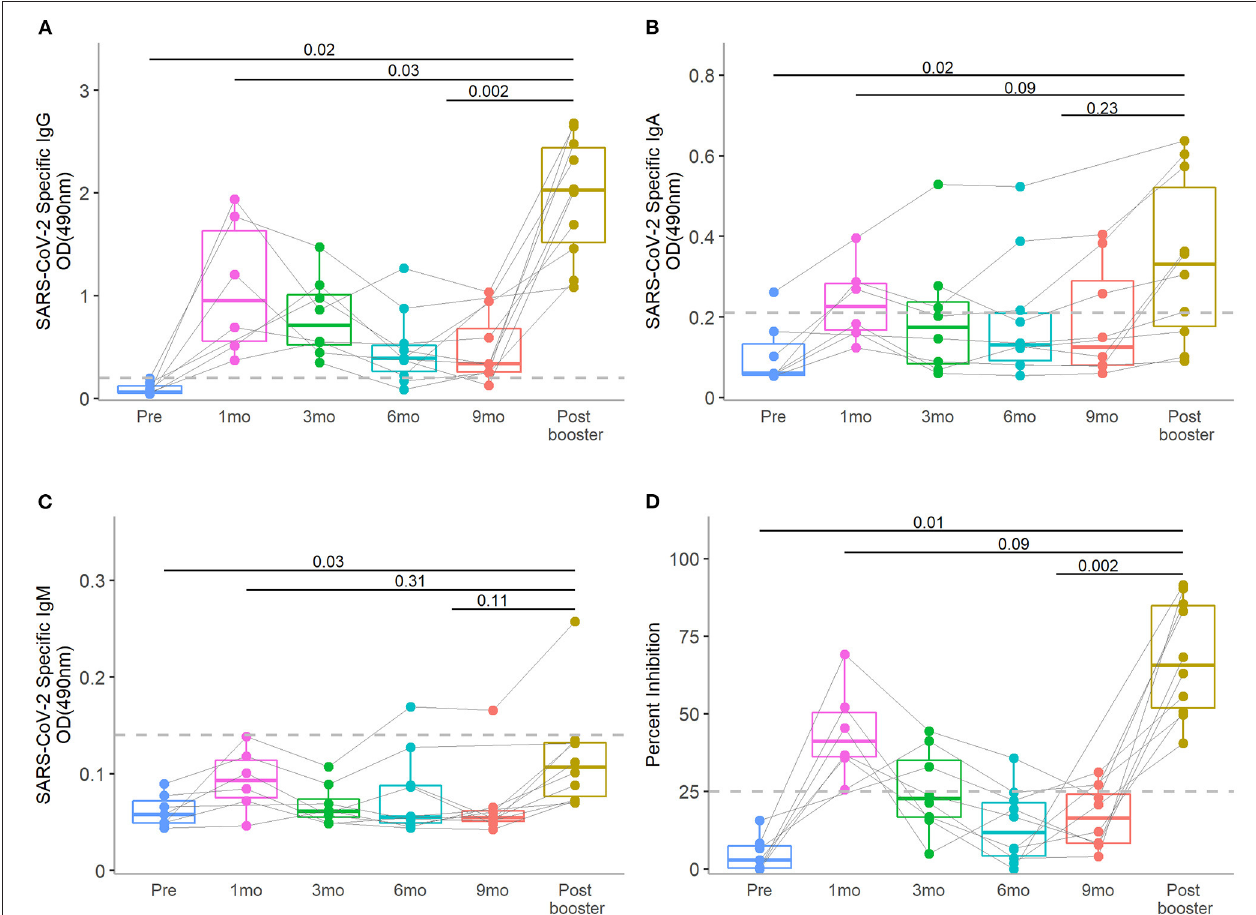
FIGURE 1 | Human milk SARS-CoV-2-specific IgG, IgA, and IgM of antibody levels and neutralizing activity at pre-vaccination: 1-, 3-, 6-, and 9-months post-primary initial vaccine and 1-month post-booster vaccine dose. The median level of SARS-CoV-2-specific IgG, IgA, and IgM and neutralization activity at the 1-month post-booster time point was compared to the peak post-primary vaccination and pre-booster time points in human milk (A–D) , respectively]. Dotted lines in y-axis indicate the positive cut-off OD 490 values of 0.20, 0.21, and 0.13 for IgG, IgA, IgM, respectively. Dotted line in y-axis of (D) indicate the positive cut-off of 25% neutralizing activity. Wilcoxon matched pairs signed rank tests were used for statistical analysis. Error bars indicate 95% confidence